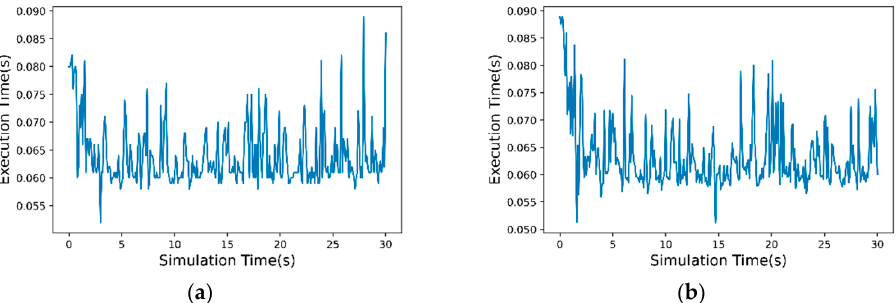
Figure 16. The execution time within each execution cycle of the proposed CLC control strategy for